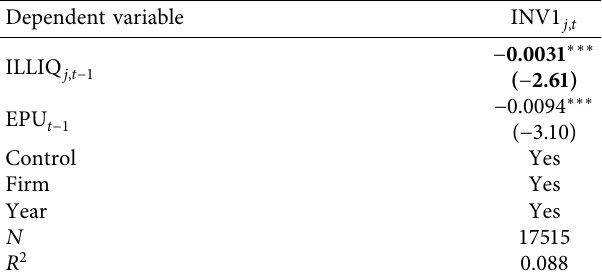
Table 8: Missing variable